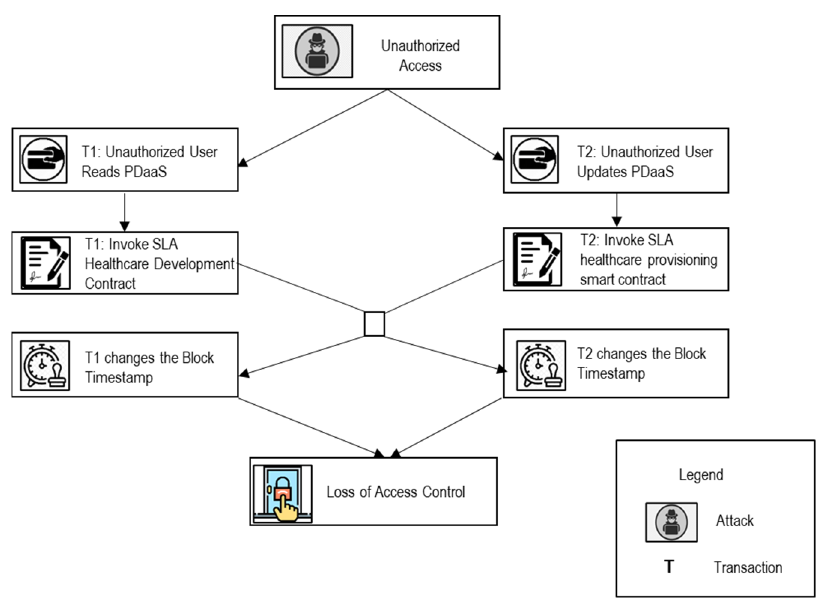
Figure 8. Threat model for timestamp dependence scenario 2: Loss of access control.